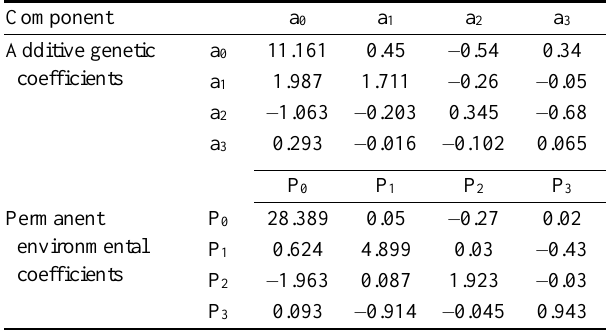
Table 2. Estimates of additive genetic and permanent environmental variances (diagonal), covariances (below diagonal) and correlations (above diagonal) for random regression coefficients of test-day protein yield (×10 3 ) Component a